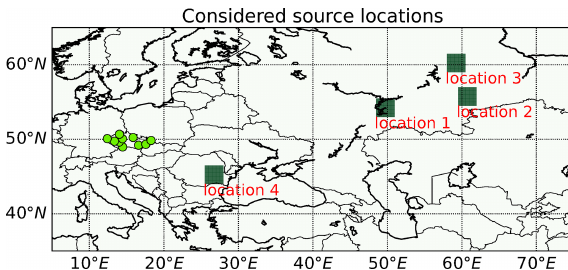
Figure 6. The four considered locations are displayed using green squares and labels. The measuring sites are displayed using green dots. Table 3. Estimated total source terms in TBq for a specific dataset (columns) and for a specific location (rows). ST: source term.